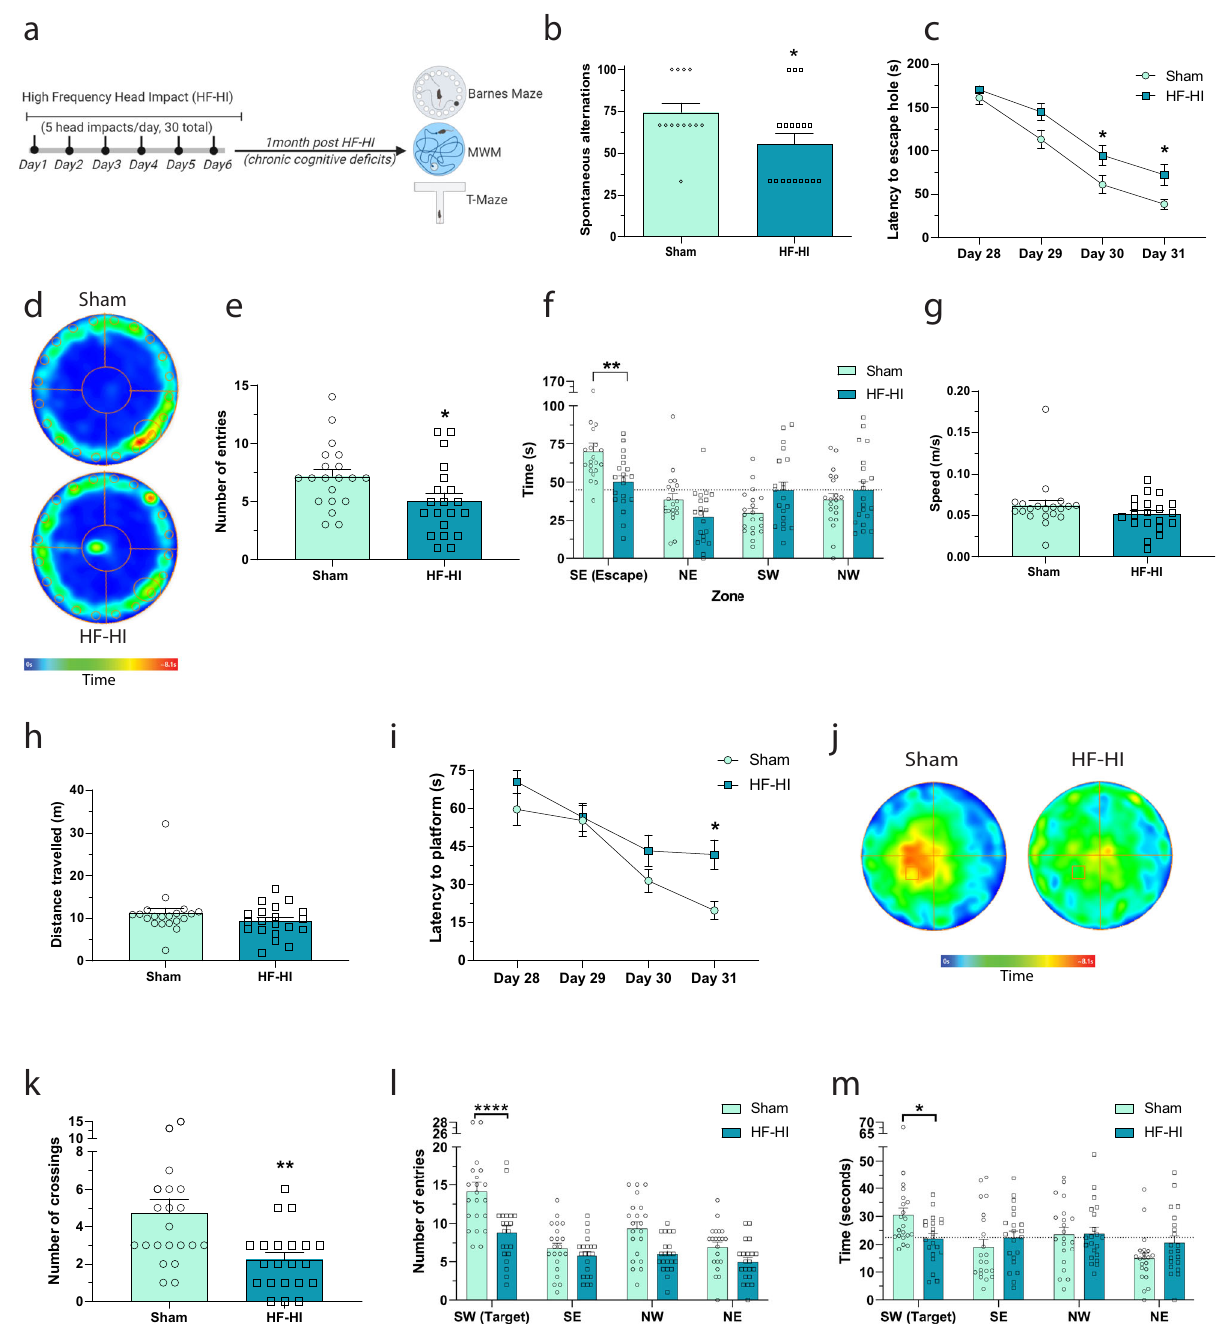
Fig. 3 HF-HI impairs chronic cognitive function. a Schematic of the experimental design for this fi gure. Mice were subject to sham or HF-HI before cognitive assessment at 1 month after the fi nal impact. b T-maze cognitive assessment at 1 month showed decreased working memory in HF-HI mice ( n